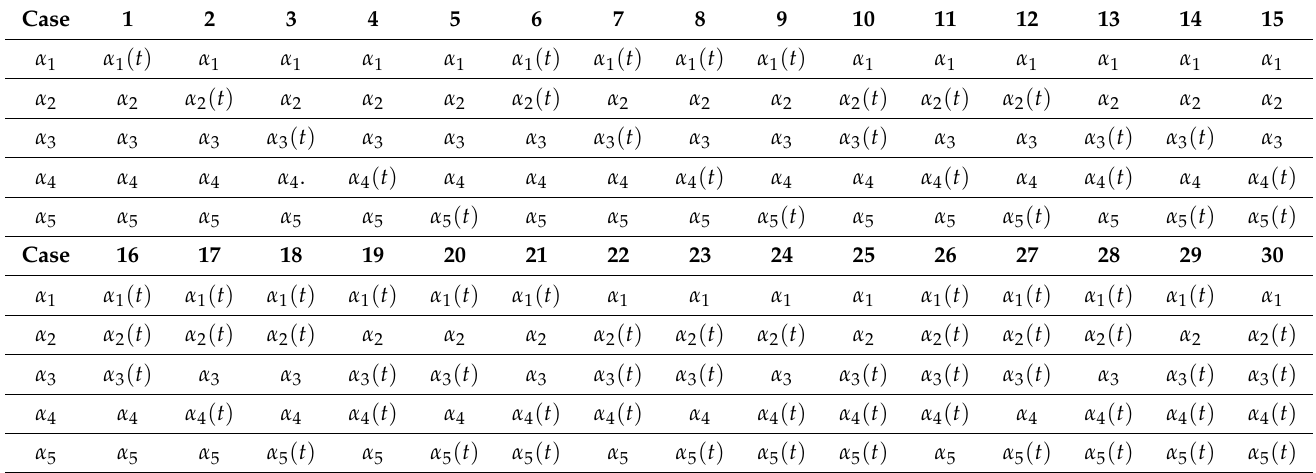
Table 3. Optimal control parameters of Cases